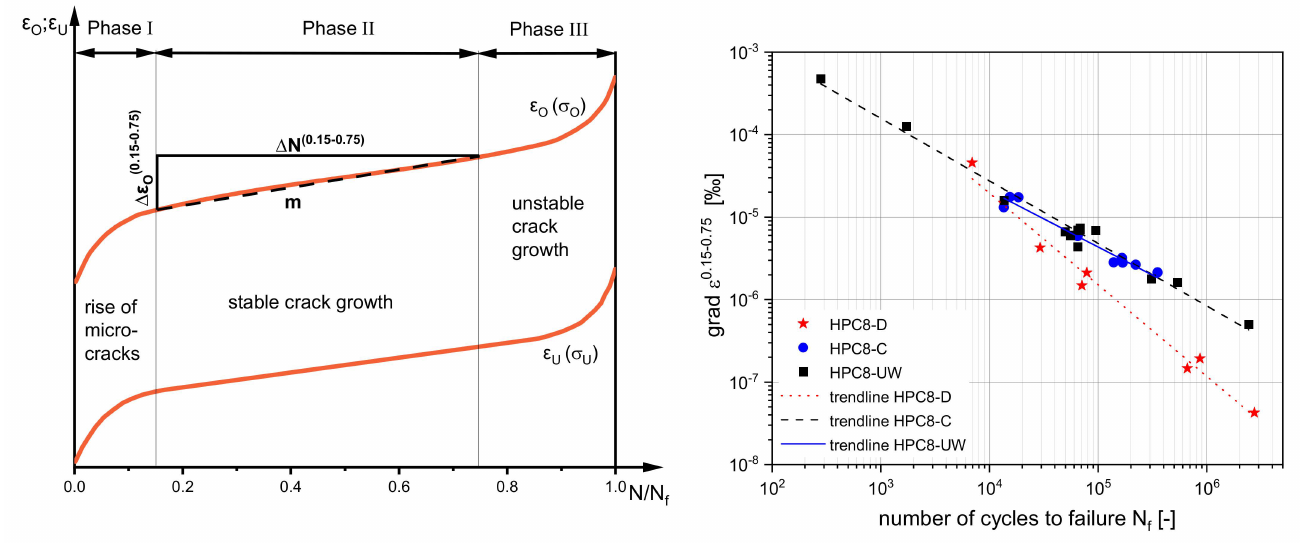
Figure 7. Schematic strain development and division into three phases ( left ). Gradient of strain in damage phase II and the associated trend lines of HPC8 ( right